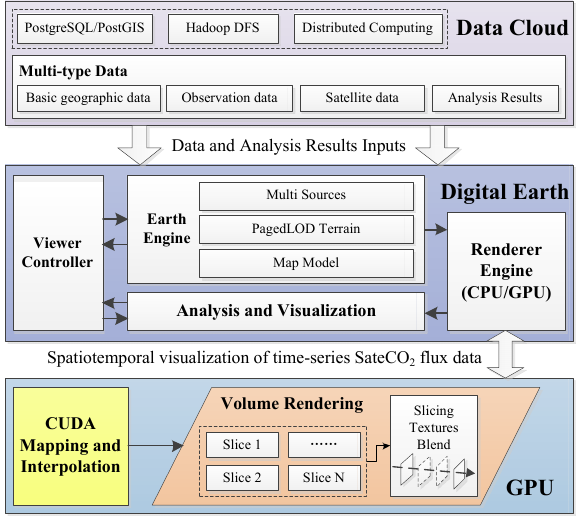
Figure 1. Spatiotemporal visualization framework on the digital earth